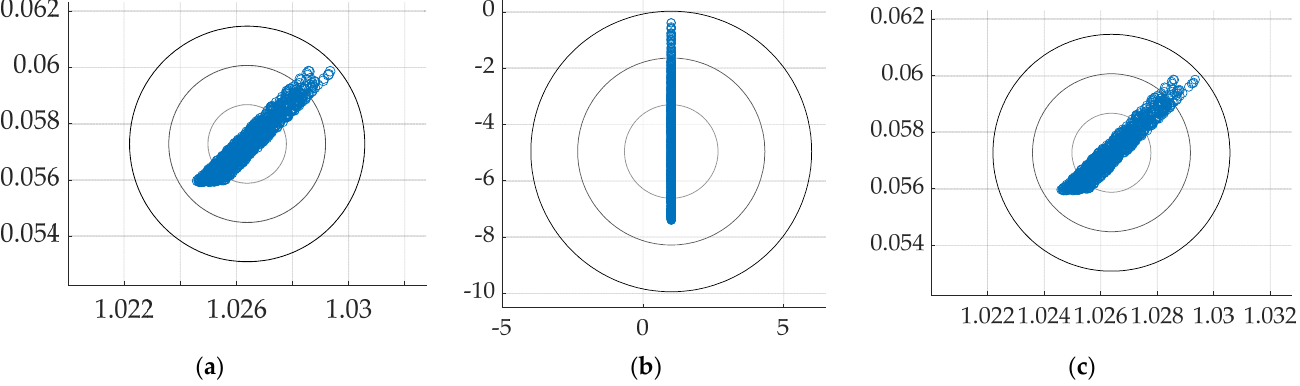
Figure 13. Comparison of the impacts of system variations on real-time optimal using ( a ) open loop optimal, ( b ) pinv without switching, ( c ) pinv with switching. Scaled state on the abscissae and scaled rate on the ordinates. Table 9. Impact of variations with real-time optimal decision methods using pinv inversion.